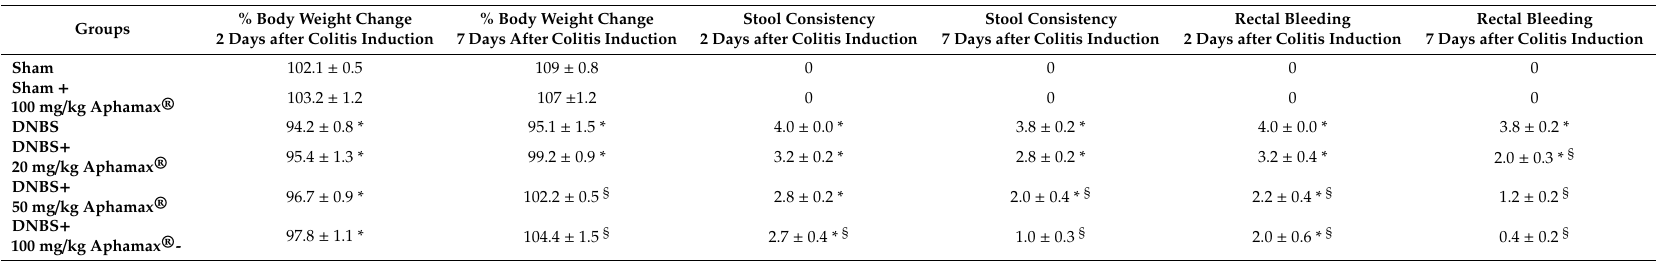
Table 2. E ff ects of Aphamax ® on body weight change, stool consistency, rectal bleeding 2- and 7- days after colitis-induction.